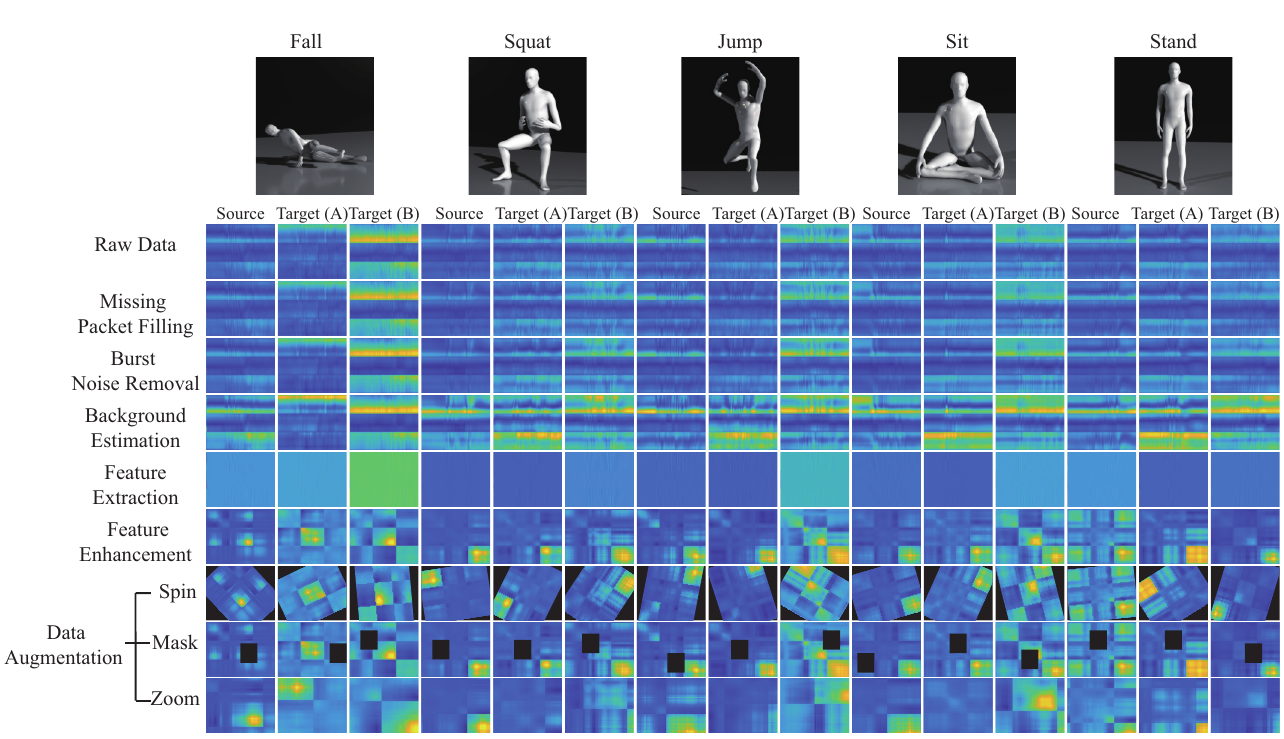
Figure 9. The 2D diagrams of CSI data